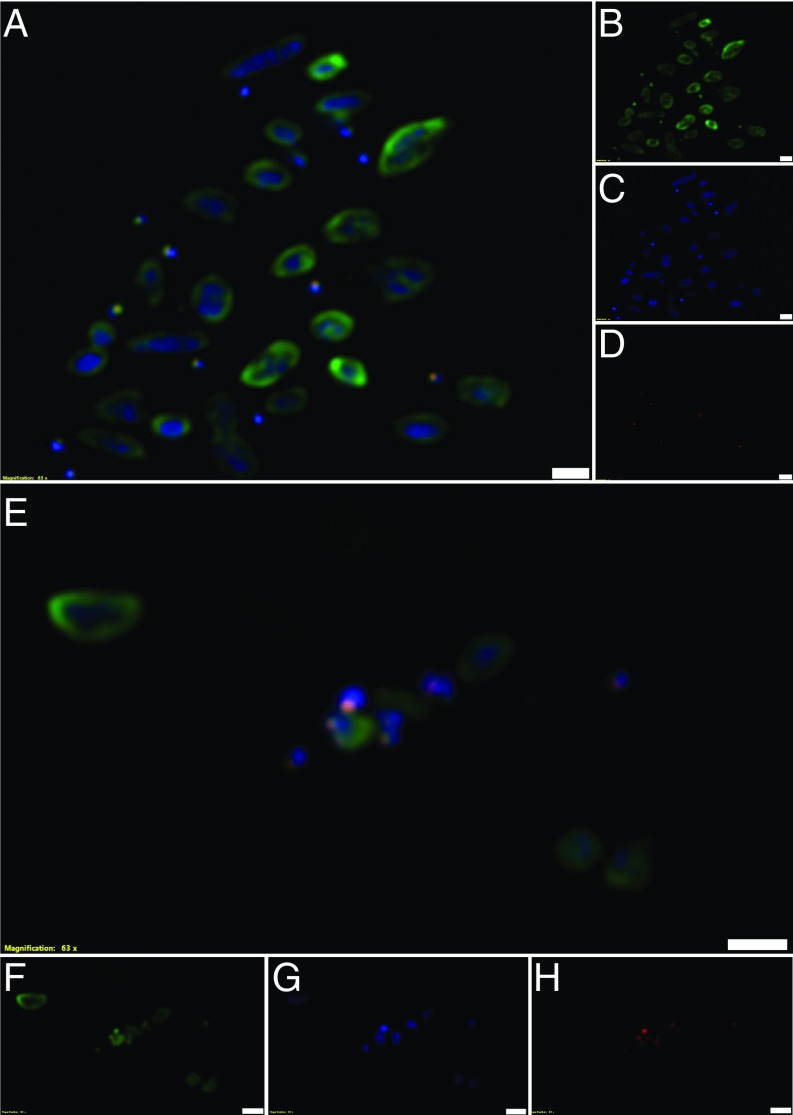
FISH of Nha-C enrichment with Hrr. lacusprofundi ACAM34-hmgA. Fluorescence micrographs show individual Nha-C cells among Hrr. lacusprofundi cells (A–D) and Nha-C cells in contact with Hrr. lacusprofundi cells (E–H). Nha-C cells are labeled with a Cy5-conjugated (red fluorescence) probe. Hrr. lacusprofundi cells are labeled with a Cy3 (yellow fluorescence; recolored to green to improve contrast) probe; all nucleic acid-containing cells are stained with DAPI (blue fluorescence). Composite image of all 3 filters (A and E). Individual filters for Cy3 (B and F), DAPI (C and G), and Cy5 (D and H). (Scale bars: 2 µm.)